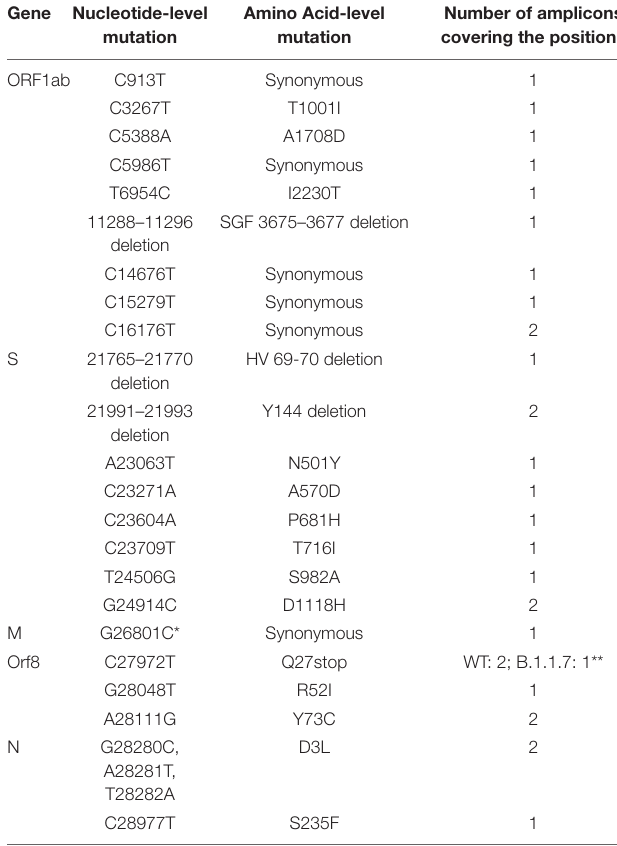
TABLE 1 | Mutations linked to SARS-CoV-2 lineage B.1.1.7 (Rambaut et al., 2021). Gene Nucleotide-level Amino Acid-level Number of amplicons mutation mutation covering the position?